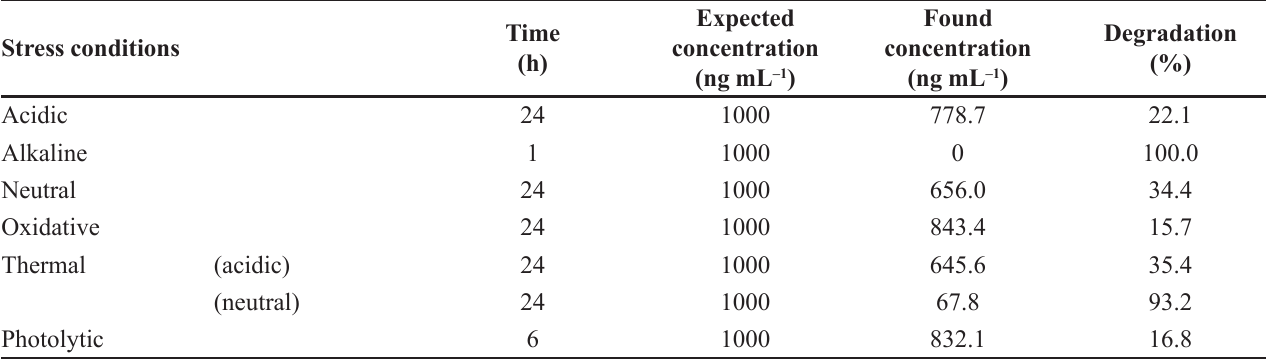
TABLE IV - Degradation percent of anisomycin under different stress conditions